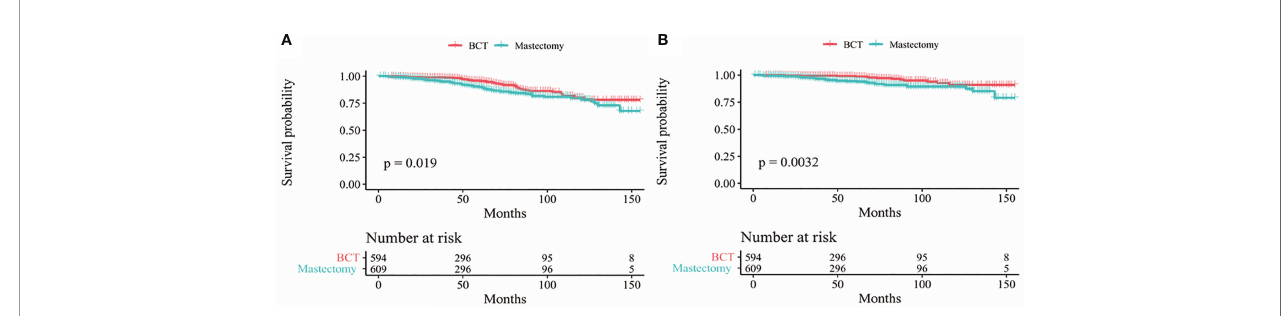
FIGURE 2 | Kaplan-Meier survival curves (A) OS between mastectomy and BCT group in the entire cohort; (B) BCSS between mastectomy and BCT group in the entire cohort. OS, overall survival; BCSS, breast cancer-speci fi c survival; BCT breast-conserving